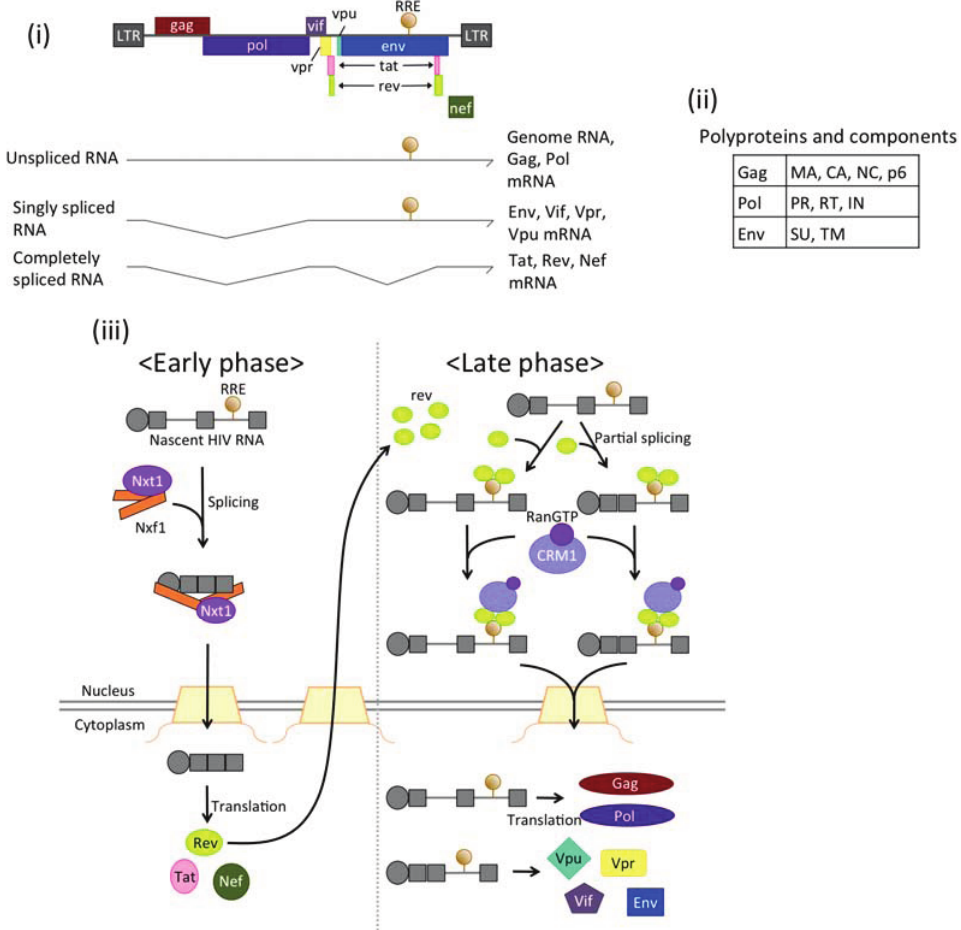
Figure 6. ( i ) Structure of the HIV-1 genome. The genome of HIV-1 encodes 15 proteins and a genomic RNA, which are all derived from a single transcript; ( ii ) The components of three polyproteins, Gag, Pol, and Env; ( iii ) mRNA export in HIV-1. In the early phase,